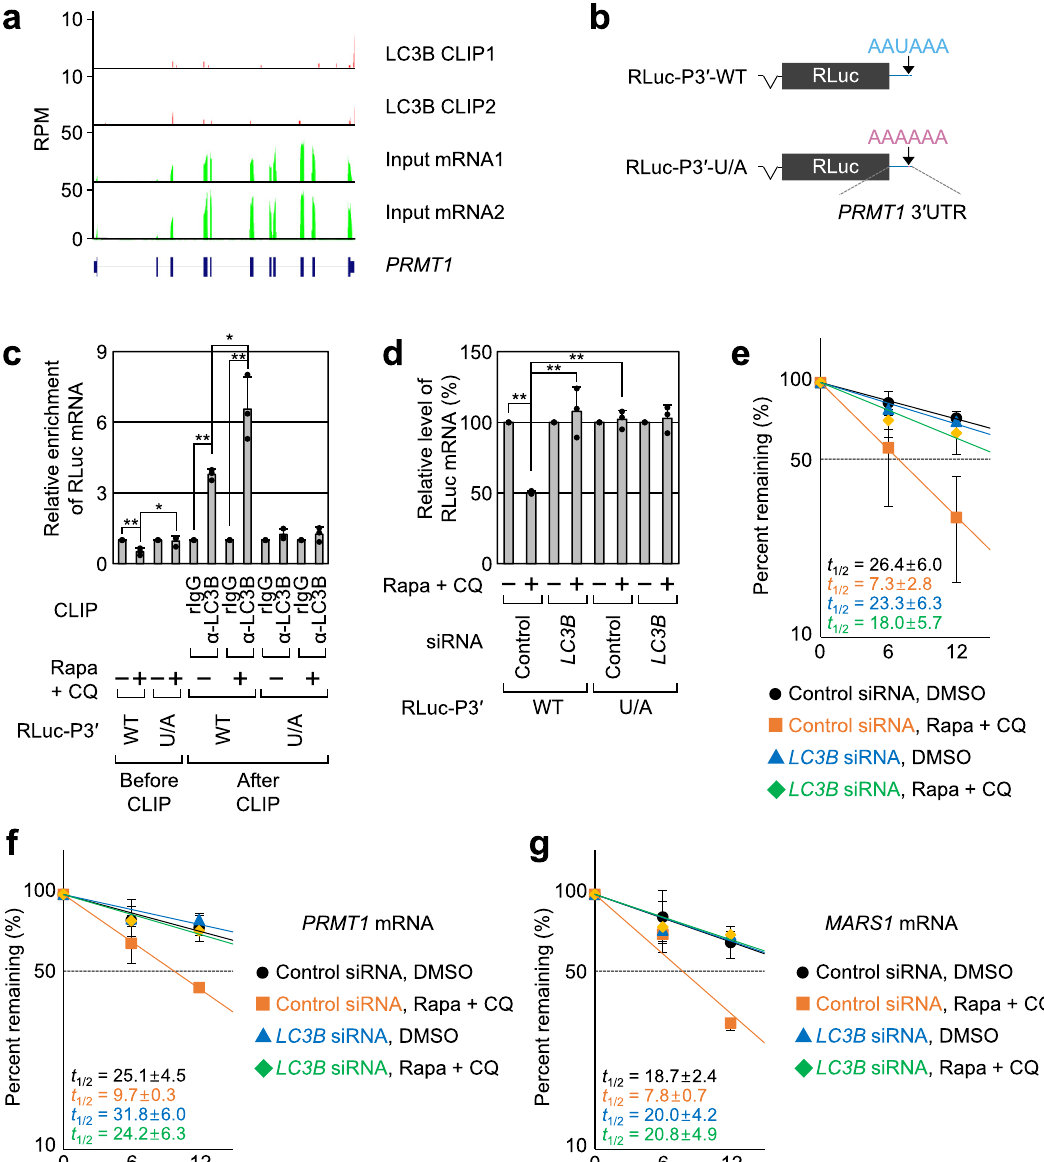
Fig. 3 PRMT1 mRNA is a de novo target of LC3B-mediated mRNA decay (LMD). a Read densities of the LC3B CLIP-seq (LC3B CLIP1 and LC3B CLIP2) and mRNA sequencing (input mRNA1 and input mRNA2) for PRMT1 mRNA in two biological replicates. The map for PRMT1 is shown at the bottom. b Schematic representation of RLuc reporter mRNAs harboring the full-length PRMT1 3 ′ UTR of either WT or U/A substitution. The relative positions of the LC3-binding site (AAUAAA) and its variant (AAAAAA) are indicated by arrows. c In vivo CLIP of endogenous LC3B. HEK293T cells expressing the RLuc reporter mRNA and FLuc mRNA (which served as a negative control) were either treated or not treated with Rapa + CQ. The cells were subjected to in vivo CLIP using α -LC3B antibody or nonspeci fi c rabbit IgG (rIgG). The amounts of coimmunoprecipitated reporter mRNAs were normalized to those of the FLuc mRNAs. Then, the normalized levels obtained in IPs using rIgG in the untreated cells were arbitrarily set to 1.0. n = 3; Data are presented as mean values ± SD; p values were analyzed using two-tailed and equal-variance Student ’ s t test; * p < 0.05; ** p < 0.01 (The exact p values are provided in Source Data fi le). d Effect of LC3B downregulation on the abundance of the RLuc-P3 ′ reporter mRNAs. HEK293T cells either undepleted or depleted of LC3B were transiently transfected with plasmids expressing RLuc and FLuc reporter mRNAs. The cells were either treated or not treated with Rapa + CQ for 12 h before cell harvest. The amounts of the RLuc mRNAs were normalized to those of FLuc mRNAs. Then, the normalized levels in the untreated cells were arbitrarily set to 100%; n = 3; Data are presented as mean values± SD; p values were analyzed using two-tailed and equal-variance Student ’ s t test; ** p < 0.01 (The exact p values are provided in Source Data fi le). e Half-life measurement of the RLuc reporter mRNA, RLuc-P3 ′ -WT. As performed in d except that the cells were harvested at the indicated time points. The y axis represents the level of mRNA remaining (percentage) on the logarithmic scale (log2); n = 4; Data are presented as mean values ± SD. f , g Half-life of endogenous LMD substrates after treatment with Rapa + CQ or LC3B downregulation. Two endogenous LMD substrates, PRMT1 mRNA ( f ) and MARS1 mRNA ( g ) were analyzed. n = 3; Source data are provided as a Source Data fi le.